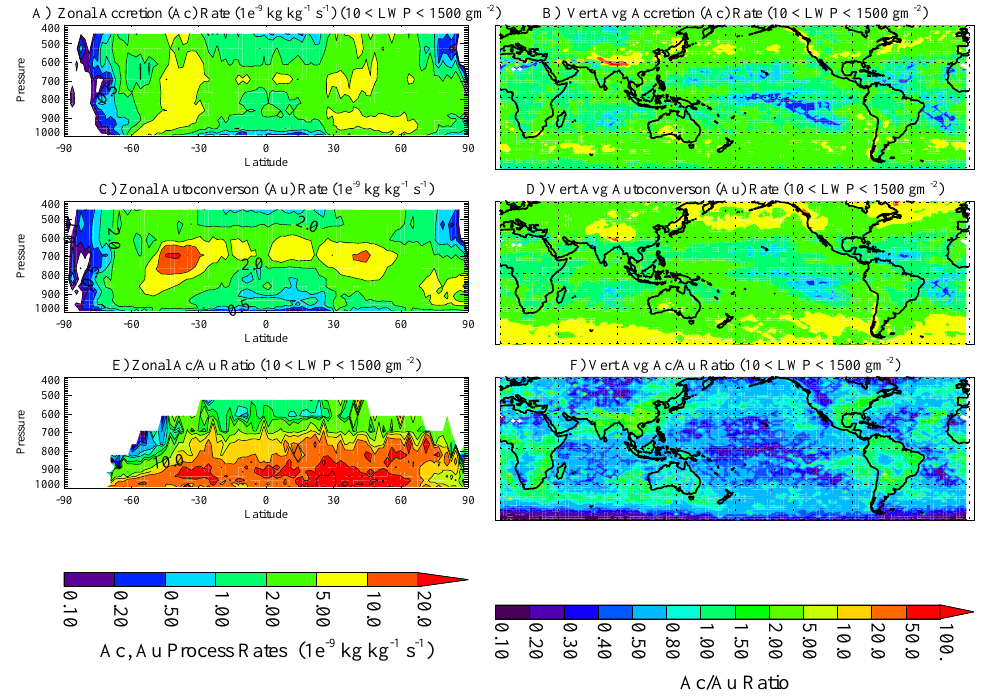
Figure 4. Zonal mean latitude height (A, C, E) and vertically averaged maps (B, D, F) of accretion rate ( A c : A, B ), autoconversion rate ( A u : C, D ), and the ratio of accretion to autoconversion rate ( A c /A u : E, F ) for all Liquid Water